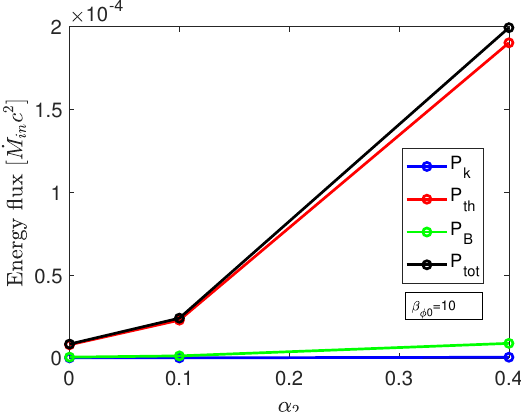
Figure 7. Bernoulli parameter in unit of v 2 pressure at the midplane.